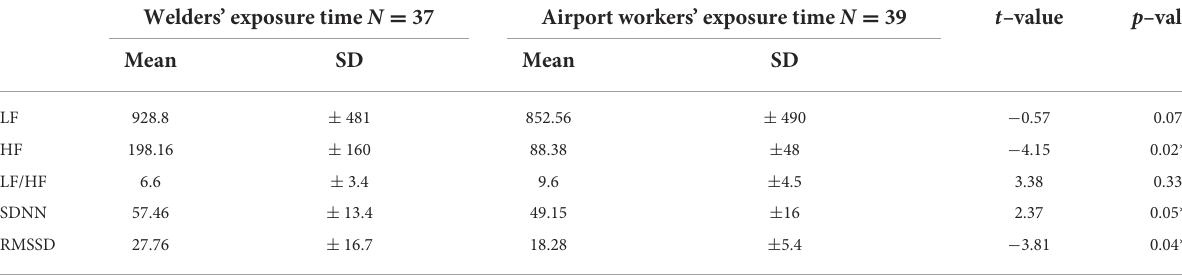
TABLE 5 Differences in time and frequency domains of HRV values between welders and airport workers. Welders’ exposure time N = 37